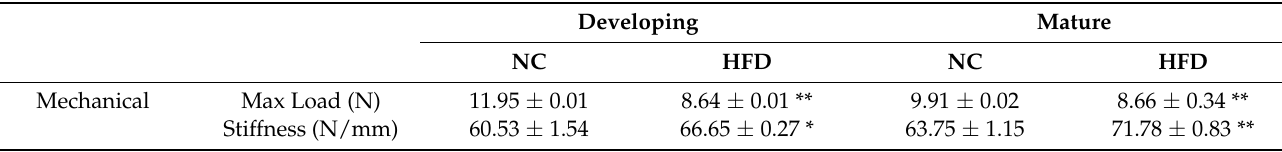
Table 3. Biomechanical parameters obtained from a 3-point bending test of the femur.